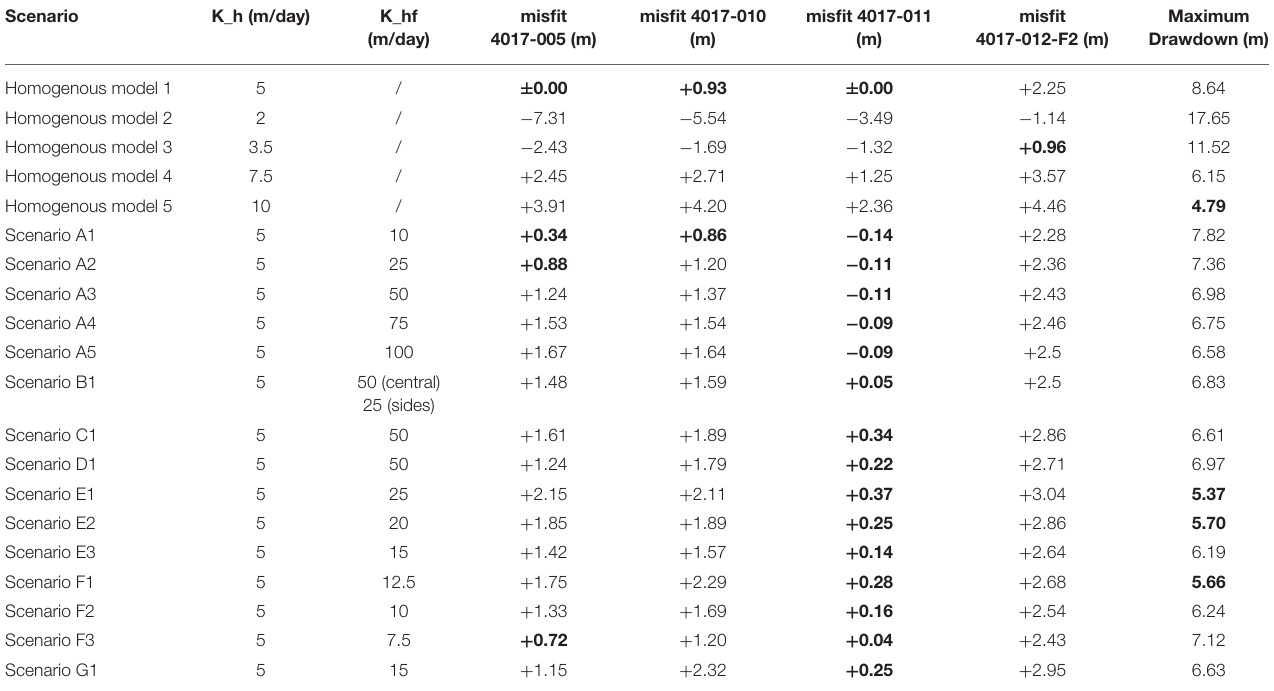
TABLE 3 | Calibration of the different